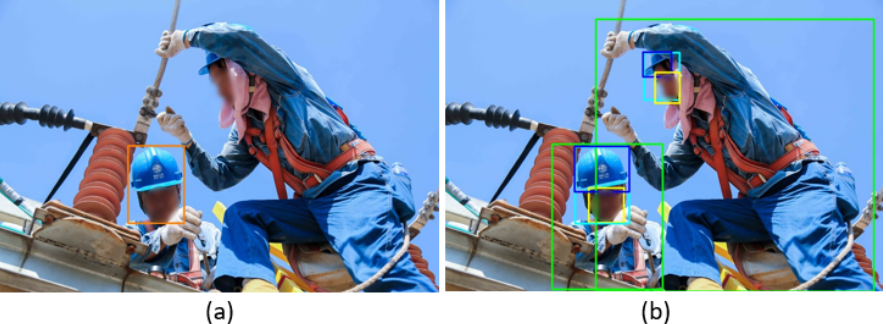
Figure 10. Comparison of the best-trained model results on the ( a ) SHW dataset [28] and the ( b ) SHEL5K